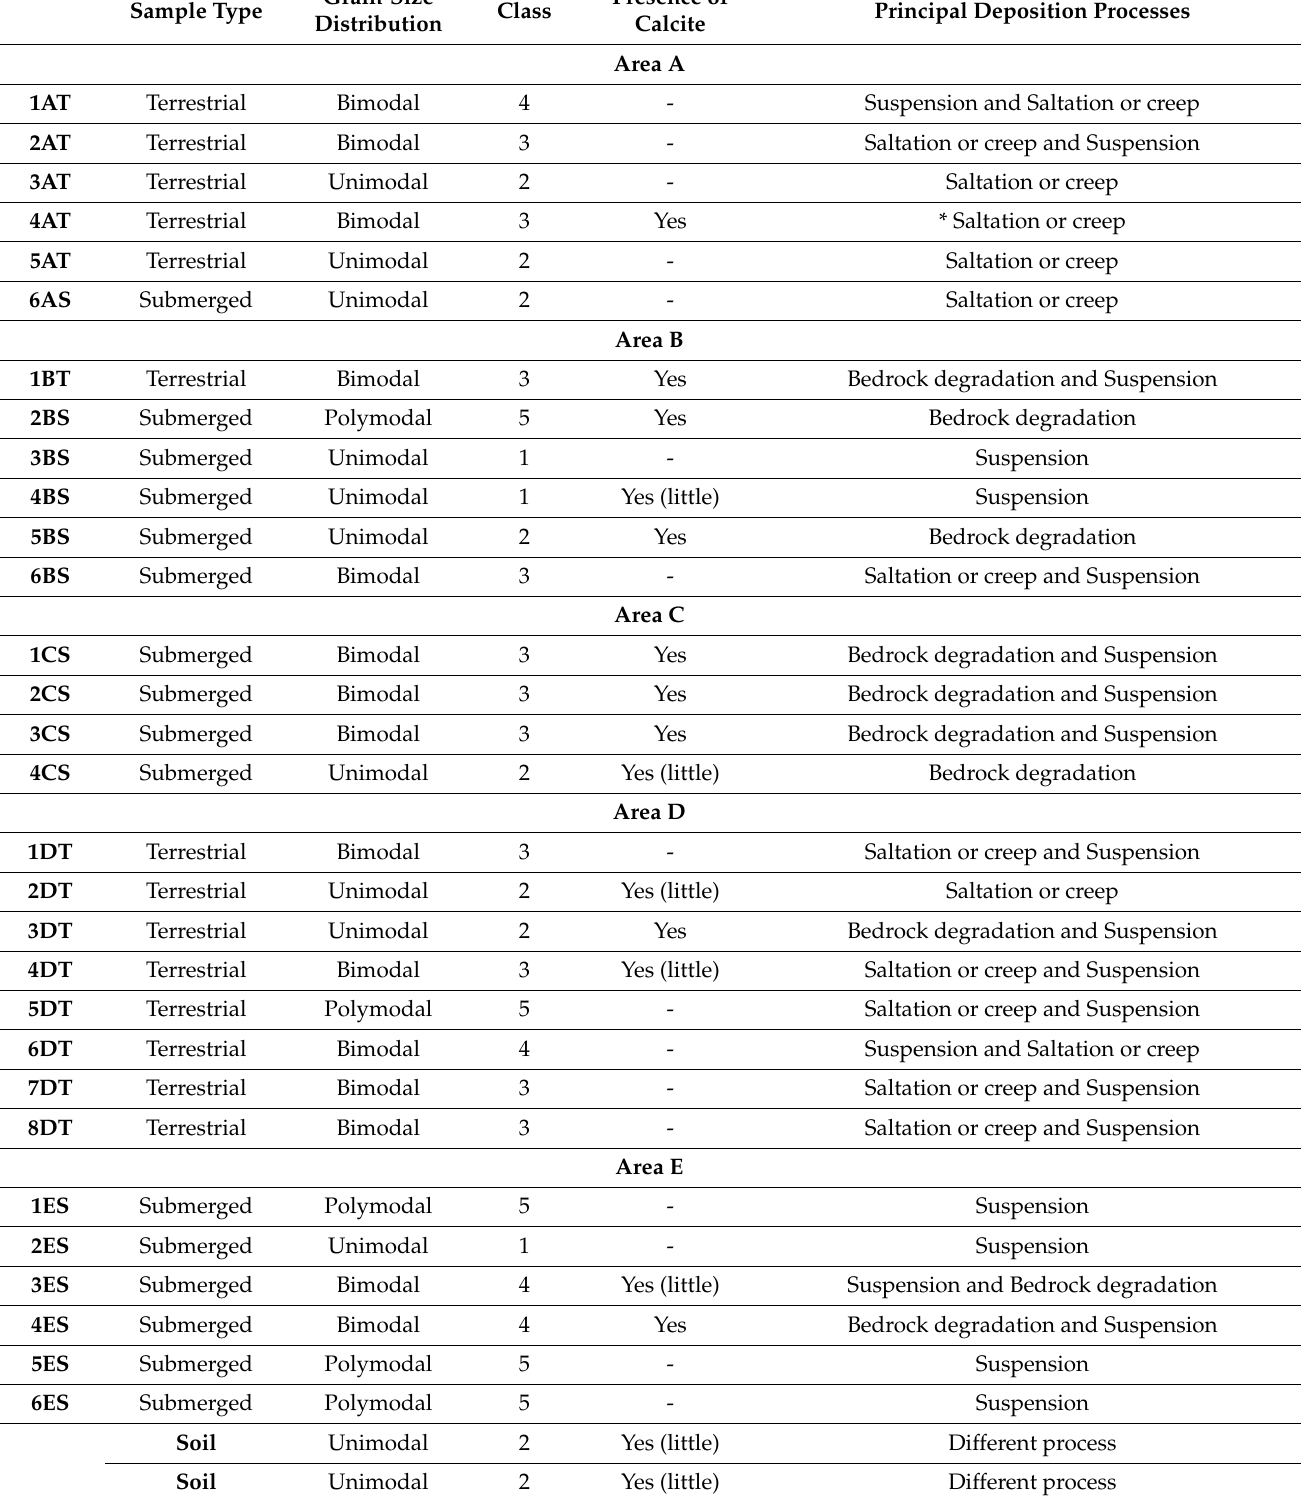
Table 6. Summary table of all grain size samples analyzed. Relationship between sample type, grain size distribution, class and the principal deposition process (the sample may be affected by more overlapping processes) in relation with the presence or not of calcite. (* 4AT is the special sample formed by